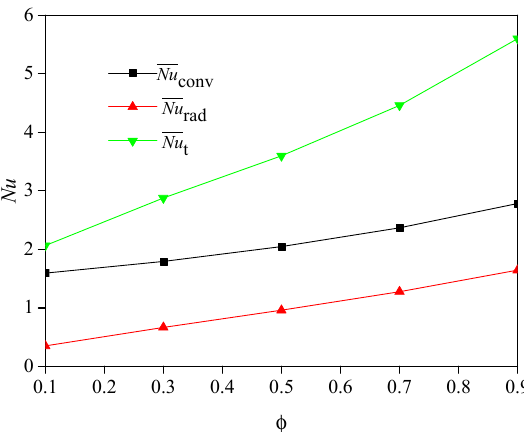
Figure 13. Variations of the average Nusselt number as a function of ϕ .